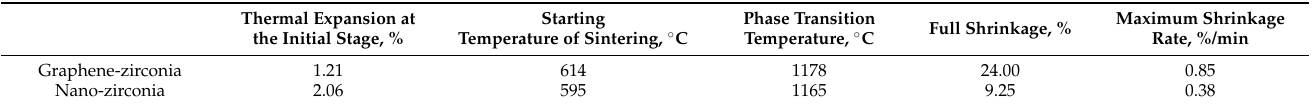
Table 1. Results of a dilatometric study of the graphene-zirconia composite and the nano-zirconia used in its